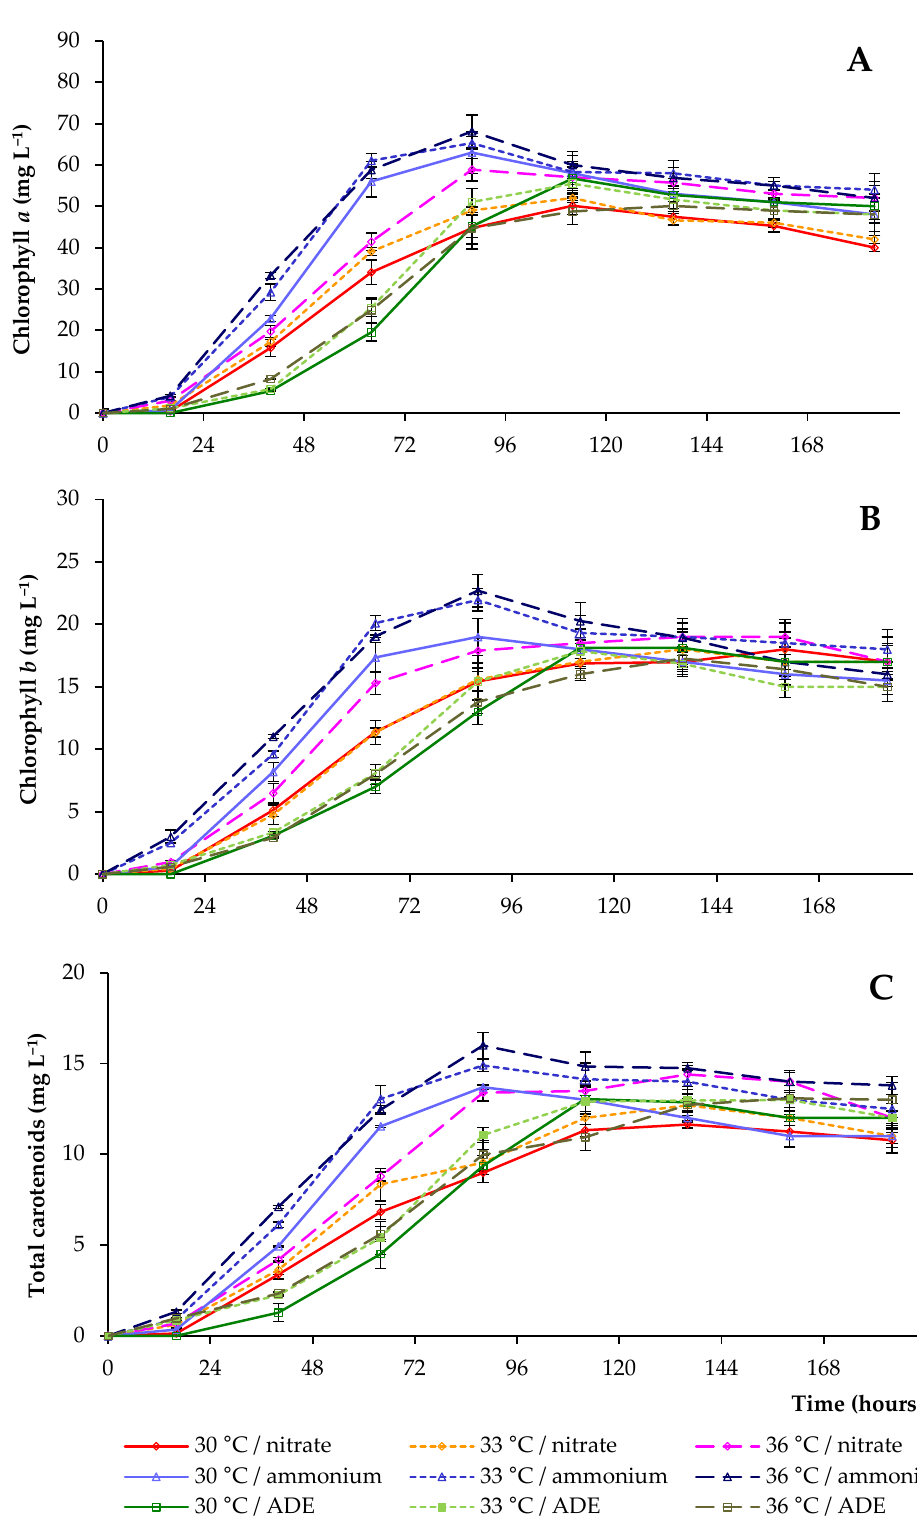
Figure 5. Pigment concentration (chlorophyll a ( A ), chlorophyll b ( B ), and total carotenoids ( C )) for cultures of C. sorokiniana AM-02 cultured under different conditions.